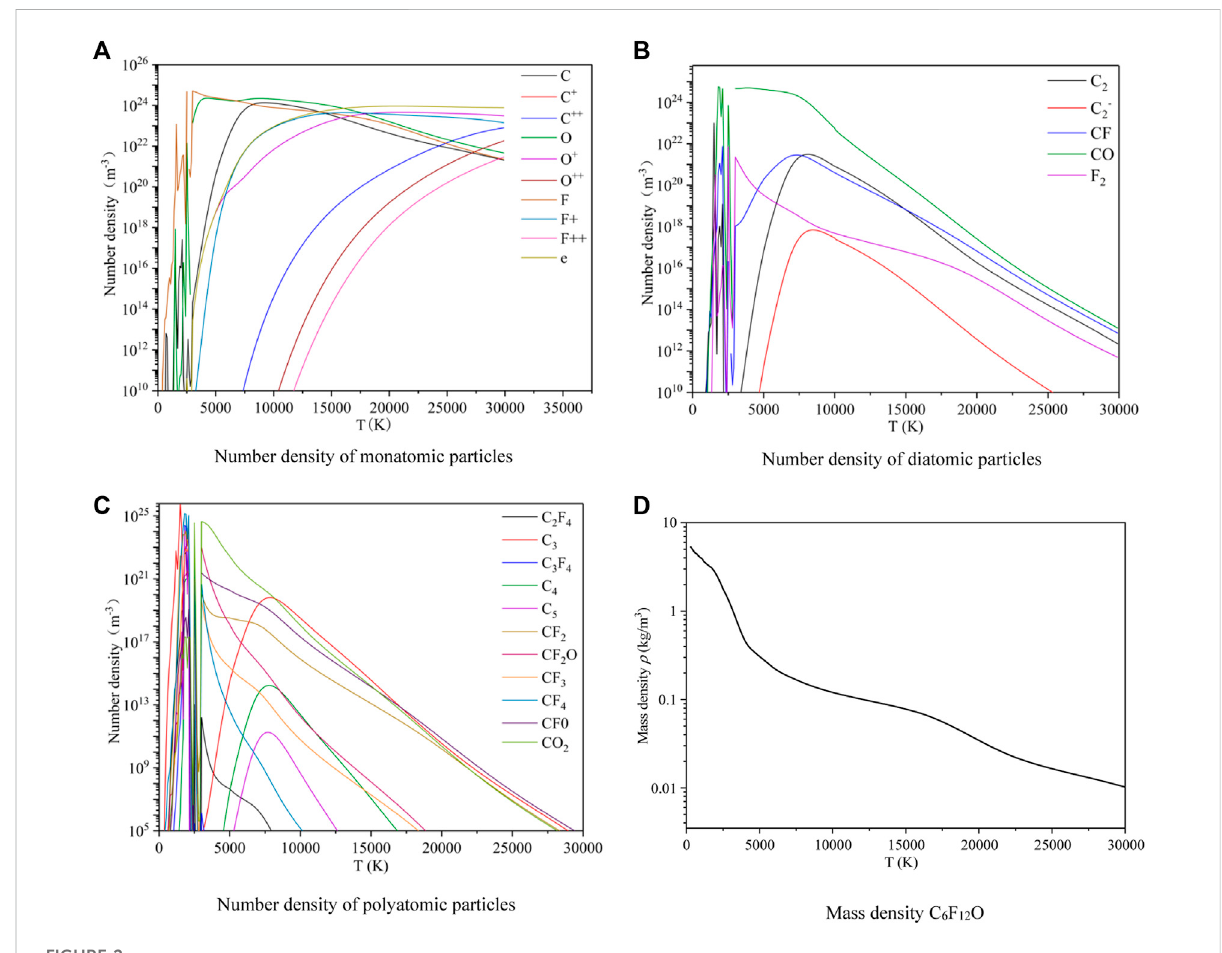
FIGURE 2 Number density and mass density of main